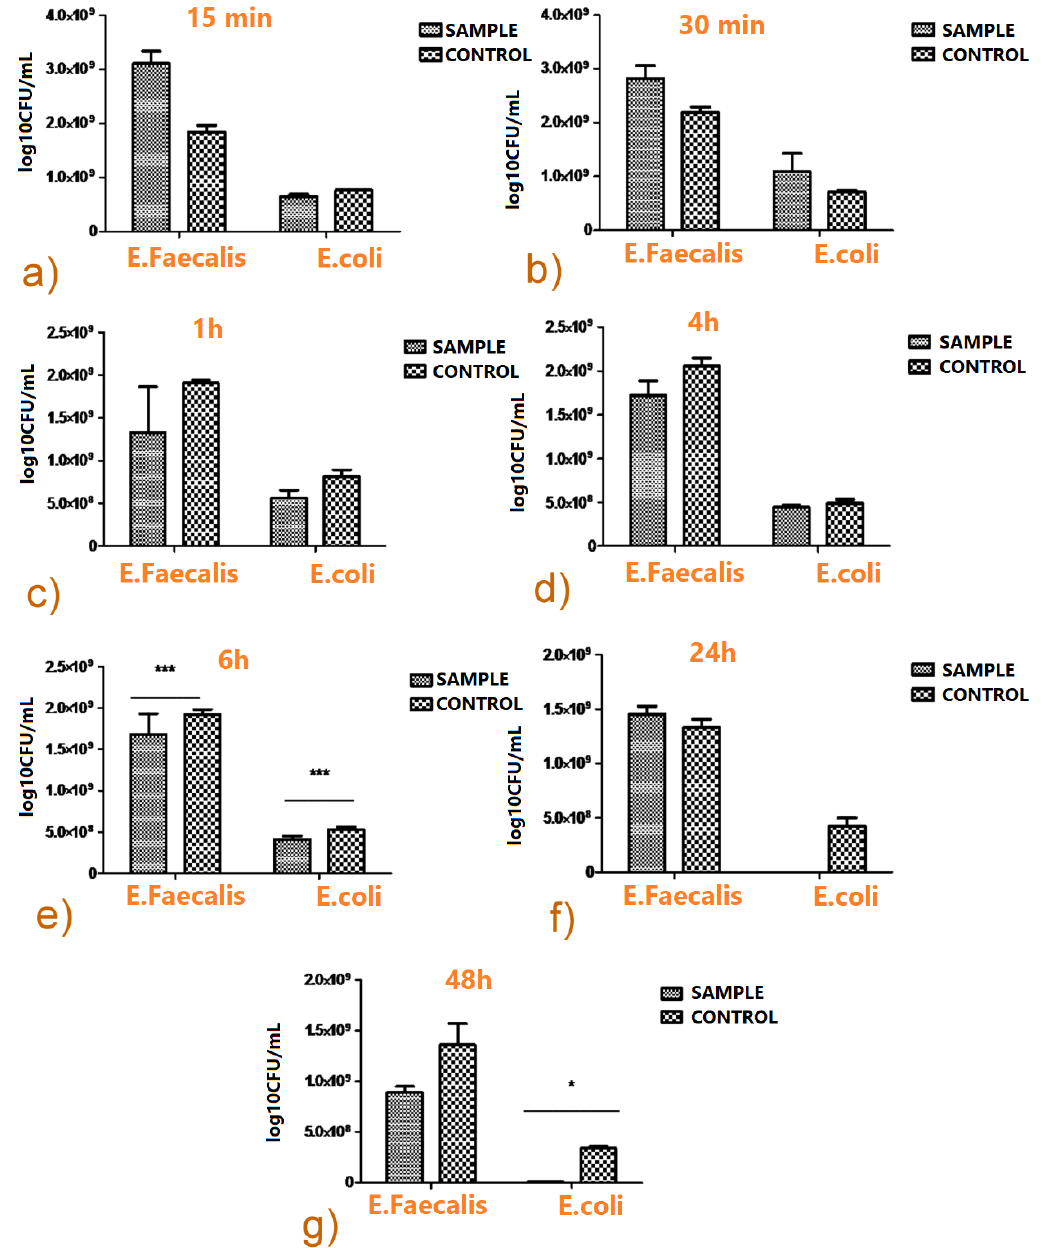
Figure 14. Microbial growth dynamics on as-deposited composite films vs. Ti control after 15 min ( a ), 30 min ( b ), 1 h ( c ), 4 h ( d ), 6 h ( e ), 24 h ( f ), and 48 h ( g ) incubation time, respectively (two-way ANOVA Bonferroni test, * p < 0.05; *** p < 0.001).